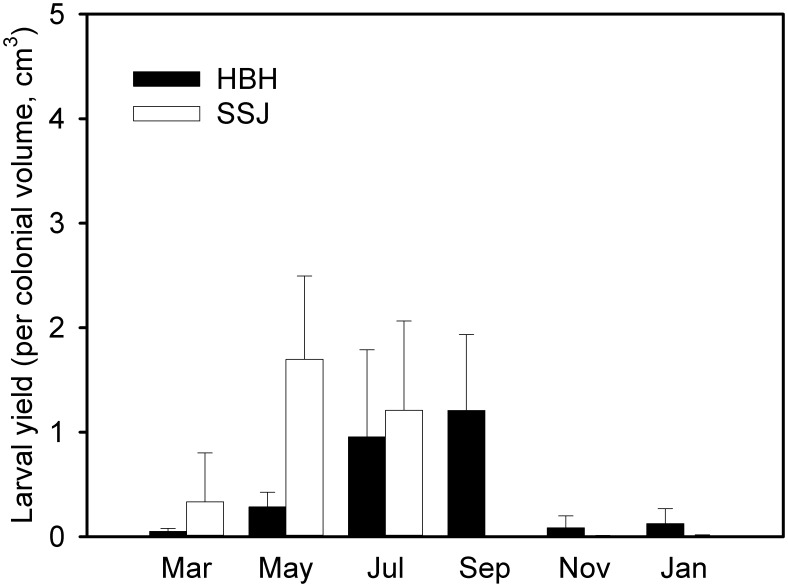
Seasonality of coral reproduction.Temporal variation of the larval yield of the coral colonies (n = 3–8, Seriatopora caliendrum) collected from the upwelling (Houbibu, HBH) and control (Siashuiku, SSJ) regions during Mar. 2011–Jan. 2012.